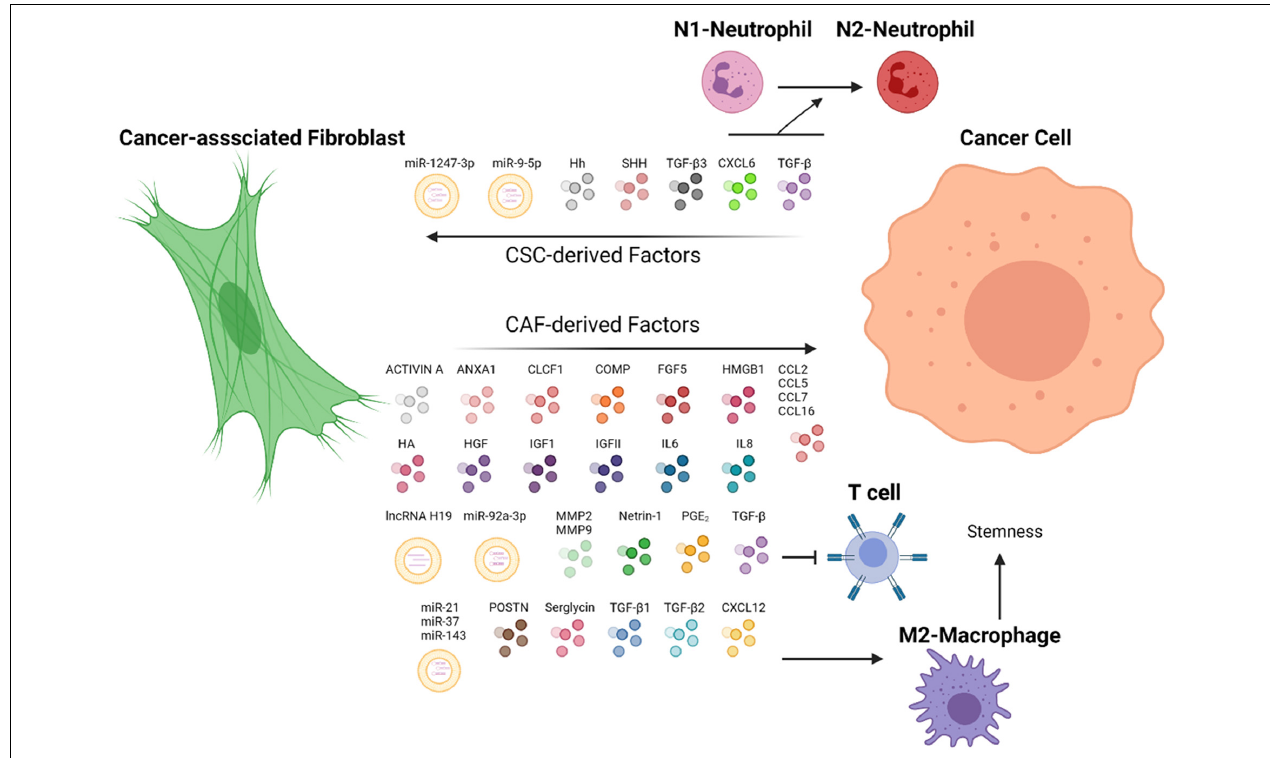
FIGURE 1 | CAF and cancer cells in a dynamic TME. CAF secretes chemokines that can potentiate stemness and metastasis properties of cancer cells via distinct pathways. In turn, cancer cells have demonstrated the capacity to direct CAF to fuel their malignant properties. Immune cells, such as T cells, macrophages, and neutrophils, are orchestrated by CAF-cancer cell interaction to promote tumor progression. ANXA1, Annexin A1; CLCF1, cardiotrophin-like cytokine factor 1; COMP, cartilage oligomeric matrix protein; CXCL6, C-X-C motif chemokine ligand 6; CXCL12, C-X-C motif chemokine ligand 12; CCL2, CC-chemokine ligand 2; CCL5, CC-chemokine ligand 5; CCL7, CC-chemokine ligand 7; CCL16, CC-chemokine ligand 16; FGF5, fibroblast growth factor 5; HA, hyaluronan; Hh, hedgehog ligand; HMGB1, high-mobility group box protein 1; HGF, hepatocyte growth factor; IGFI, insulin-like growth factor 1; IGFII, insulin-like growth factor 2; IL6, interleukin 6; IL8, interleukin 8; MMP2; matrix metalloproteinase-2; MMP9, matrix metalloproteinase-9; POSTN, periostin; PGE 2 , prostaglandin E 2 ; SHH, sonic hedgehog ligand; TGF- β , transforming growth factor- β ; TGF- β 1, transforming growth factor- β 1; TGF- β 2, transforming growth factor- β 2; TGF- β 3, transforming growth factor- β 3; WNT3a, Wnt Family Member 3A. The figure is created with